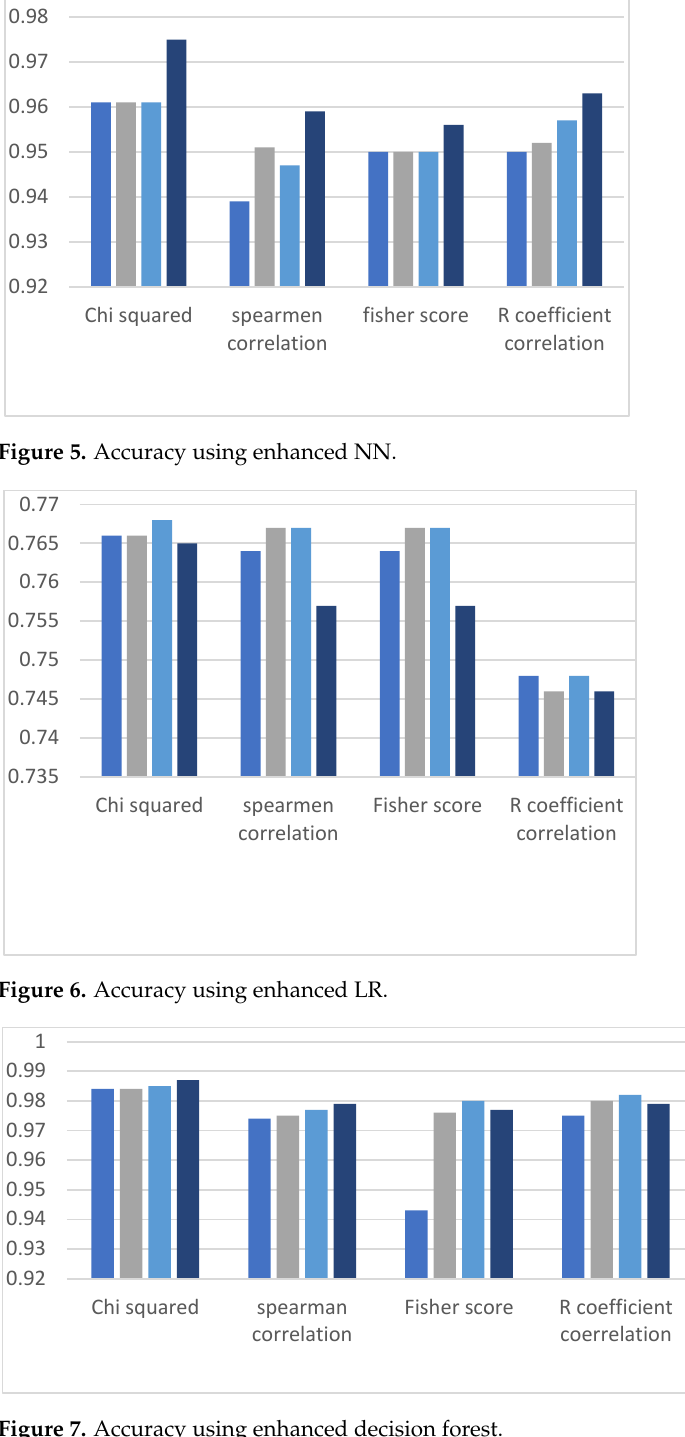
Figure 7. Accuracy using enhanced decision forest.